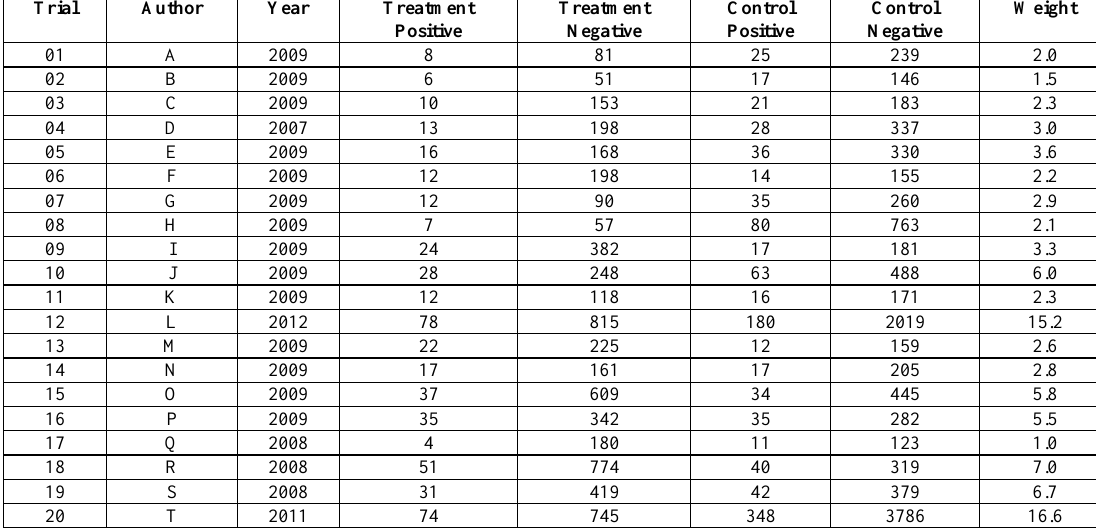
Table 1. Data for age-related macular degeneration (AMD) disease